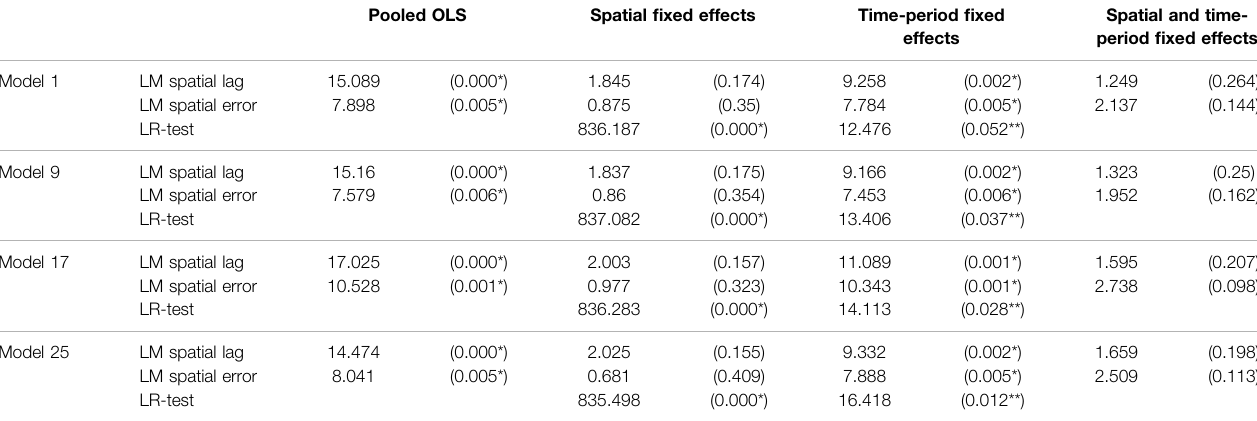
TABLE 4 | Spatial lag or the spatial error in the spatial and time-period fi xed-effects model.